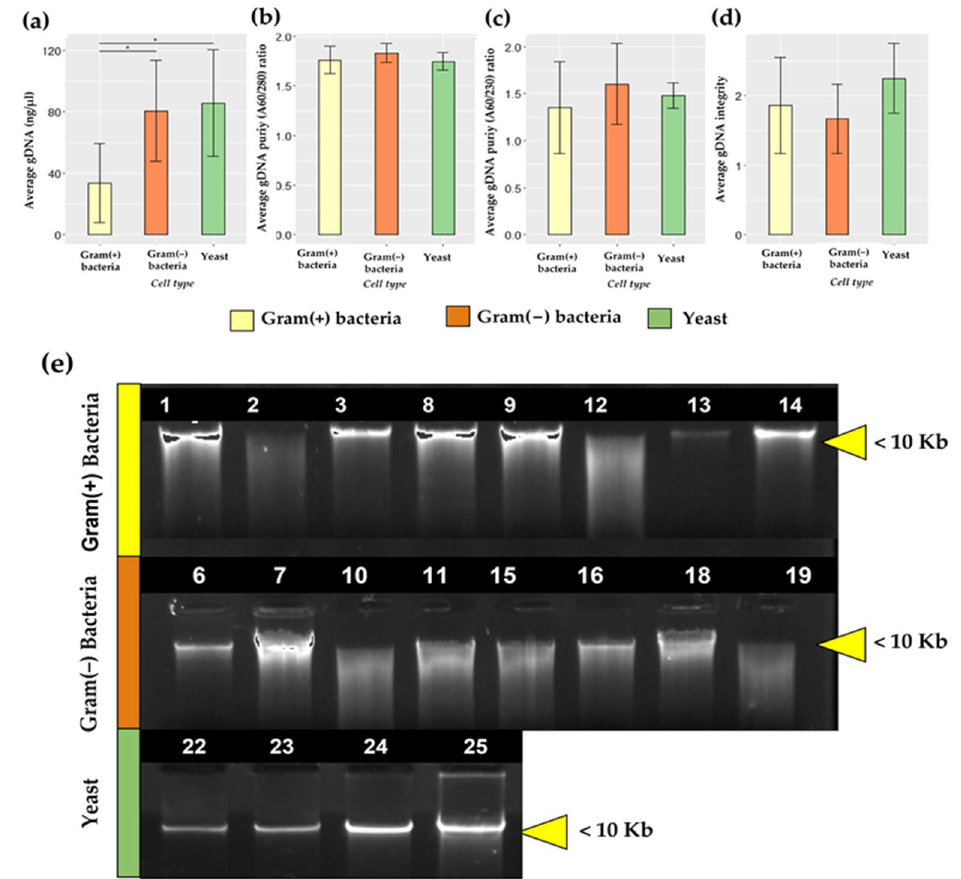
Figure 2. Quantity and quality of DNA from microorganisms isolated using the CTAB-STD method. ( a ) Bar plots showing the DNA concentration (ng/μL). ( b ) Bar plots showing the DNA purity at 260/280 nm. ( c ) Bar plots showing the DNA purity at 260/230 nm. ( d ) Bar plots showing the DNA integrity of the three cell types assessed. ( e ) Representative results from gel electrophoresis analysis of gDNA from microorganisms isolated using the CTAB-STD method. The bar signifies the mean. The line inside the bars represents the standard deviation. p -values for differences between the different cell types were calculated using an ANOVA statistic. When the difference between regions was significant ( p < 0.05), all pairwise comparisons were tested for significance using the Tukey–Kramer multiple comparisons test (HSD). * Represents significance was p < 0.05. Yellow represents values for Gram(+) bacteria, orange represents values for Gram(−) bacteria, and green represents values for yeast.